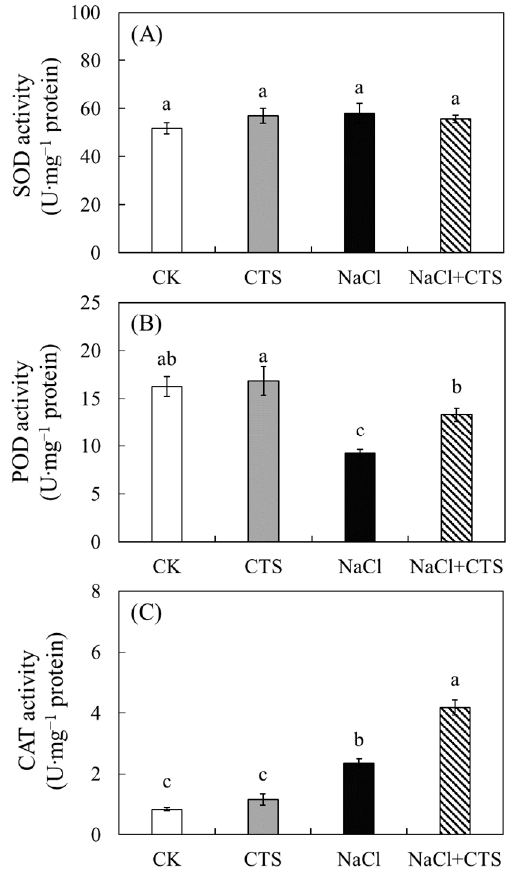
Figure 4. Effects of exogenous chitosan (CTS) on activities of ( A ) SOD, ( B ) POD, and ( C ) CAT in leaves of lettuce plants under salt stress. Data presented are the means ± SEs ( n = 3). Different letters on top of bars indicate a significant difference ( p < 0.05) according to Tukey’s HSD test. CK (control) = 0 mM NaCl + 0 mg/L CTS; CTS = 0 mM NaCl + 100 mg/L CTS; NaCl = 100 mM NaCl + 0 mg/L CTS; NaCl + CTS = 100 mM NaCl +100 mg/L. SOD, superoxide dismutase; POD, peroxidase; CAT, catalase.